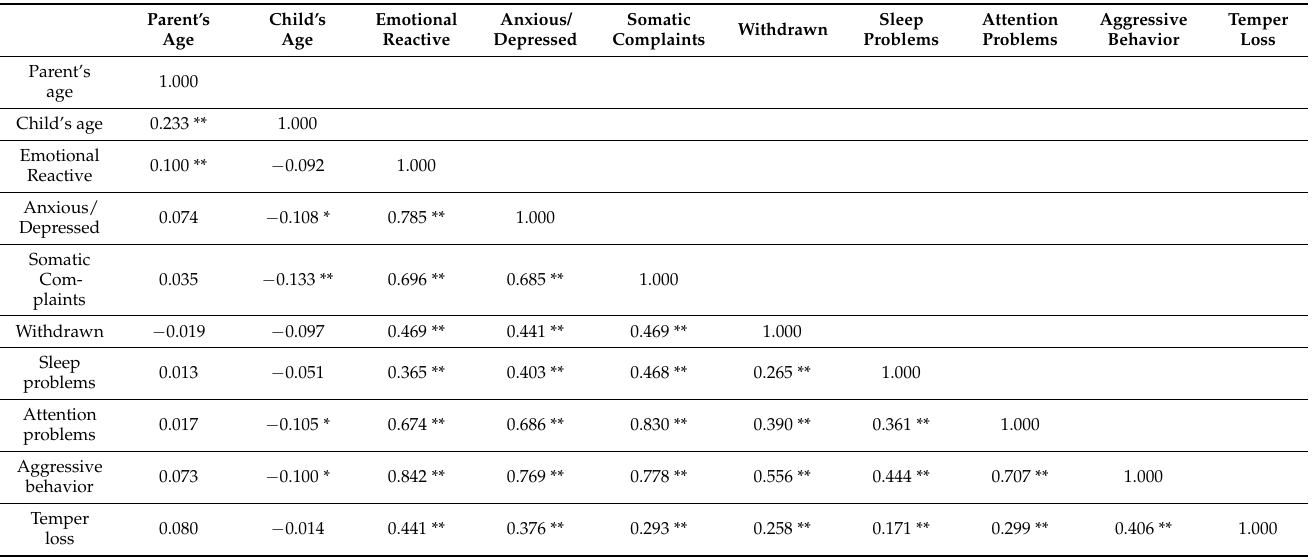
Table 4. Correlations (Spearman’s rho) between CBCL subscales and scale of MAB-DB (N = 400).